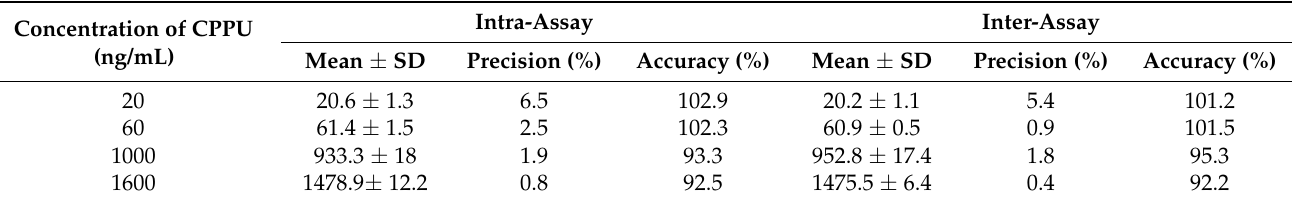
Table 1. Inter- and intra-assay accuracy and precision of CPPU detection in rat plasma ( n = 5).